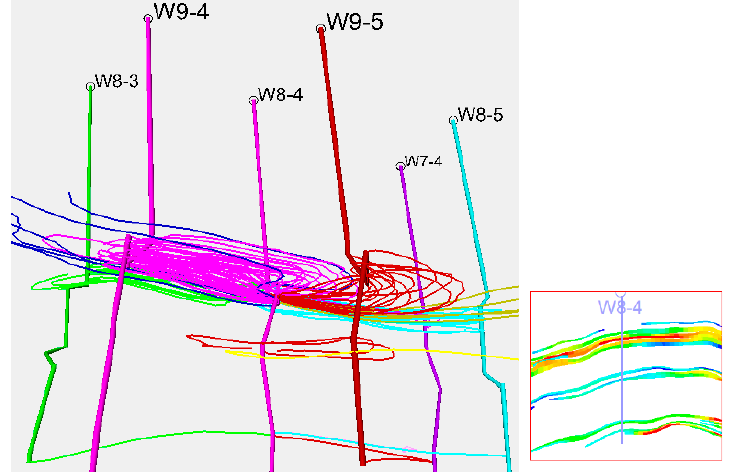
Processes 2018 , 6 , x FOR PEER REVIEW Figure 13. The vertical polymer streamline model of the well W8-4. Figure 13. The vertical polymer streamline model of the well W8-4.